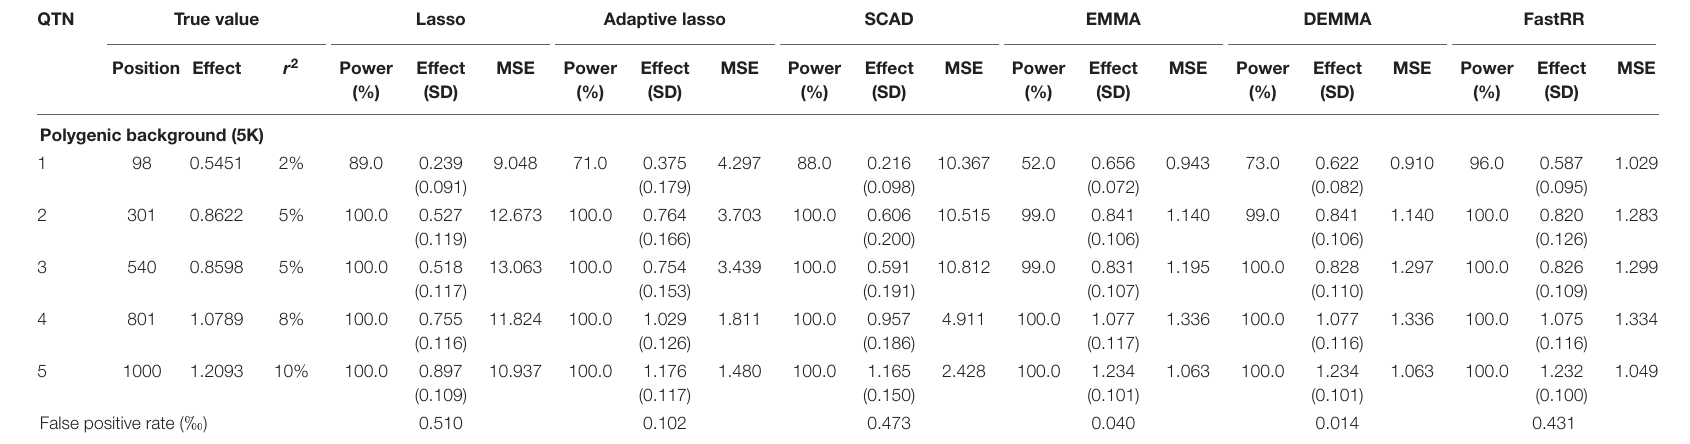
Three scenarios, including two times polygenic background, five times polygenic background, and ten times polygenic background. MSE, mean squared error. The numbers in parentheses represent the standard